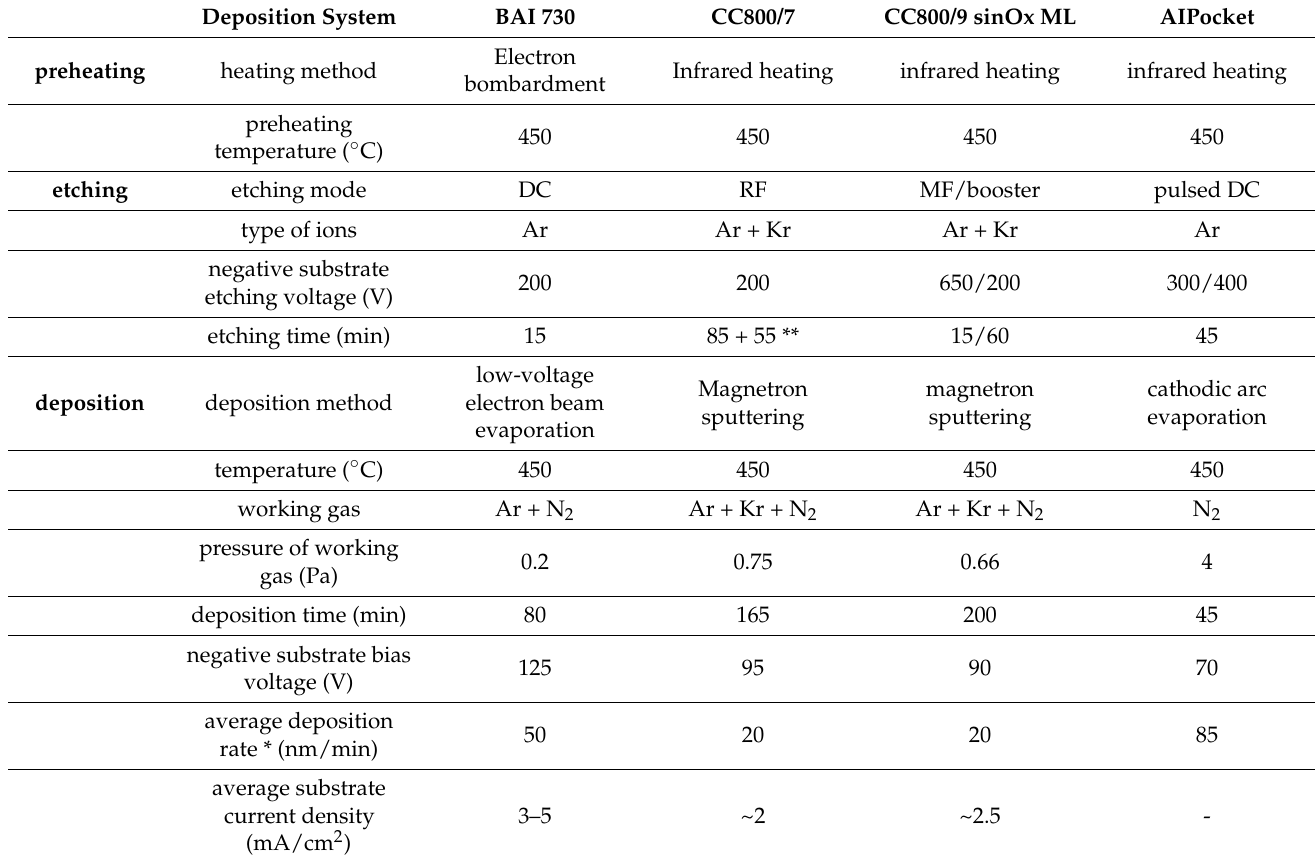
Table 1. Deposition methods and process parameters used for the preparation of PVD hard coatings. The deposition rates and ion current density are averages since all deposition techniques exhibited both spatial and temporal variations during a given deposition run as well as from one run to another run (depending on batching